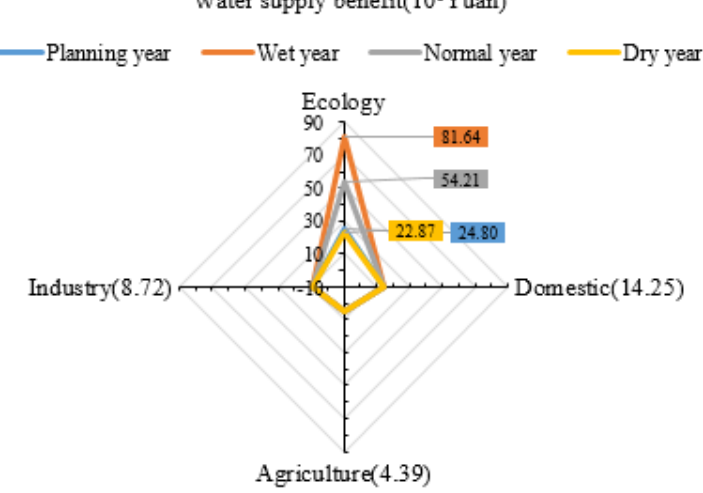
Figure 6. Water supply benefits of Hekoucun reservoir in different types of years.